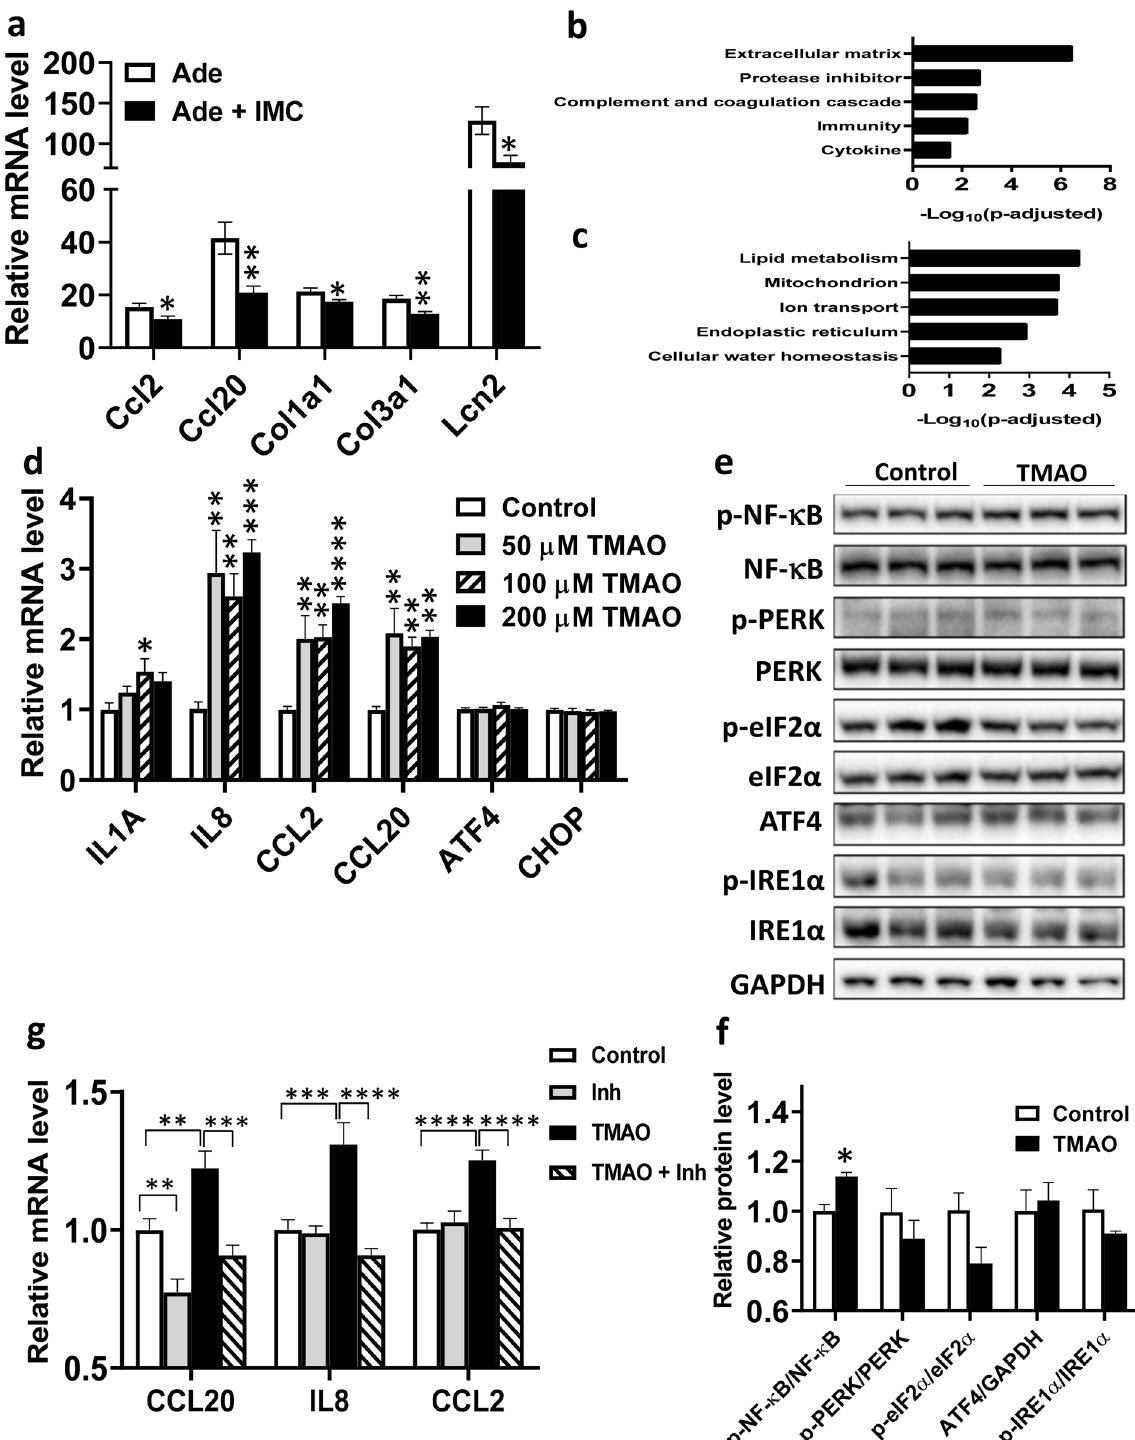
Figure 2. Inhibition of TMAO generation decreases inflammation and fibrosis in the kidneys of adenine diet-induced CKD. Gene expression analysis of kidney samples from the same mice described in Fig. 1 were performed using qPCR ( a ), n = 8 to 9 per group, and RNA-seq ( b , c ). Based on the RNA-seq data, pathway enrichment analysis was performed to identify down-regulated ( b ), and up-regulated ( c ) functional clusters in the kidneys of Ade + IMC group compared to the Ade group (n = 6 per group). Gene expression ( d , n = 4–5/group) and immunoblotting ( e , f , n = 3/group) analysis of MDCK II kidney epithelial cells treated with control, and various doses of TMAO ( d ) or 200 μM of TMAO ( e , f ) for 48 h. ( g ) MDCKII cells were treated with control media, 100 nM NF-κB inhibitor IV (Inh), 200 μM TMAO (TMAO), or 200 μM TMAO + 100 nM NF-κB inhibitor IV (TMAO + Inh) for 48 h before gene expression analysis (n = 9 for each group). For ( a , f ), two tailed Student’s t-test was performed. Symbols: *p < 0.05, and **p < 0.01. For ( d ) Post hoc Tukey’s multiple comparisons test was performed after significant one-way ANOVA. Symbols: *p < 0.05, **p < 0.01, ***p < 0.001, and ****p < 0.0001 compared to the control group. For ( g ) Post hoc analysis was performed after significant two-way ANOVA. Symbols: **p < 0.01, ***p < 0.001, and ****p <